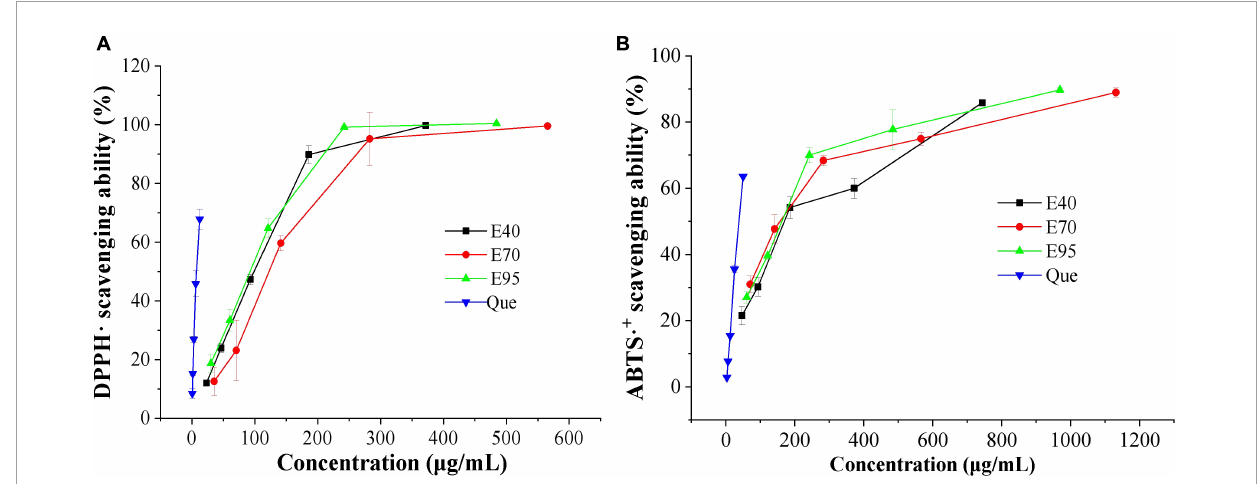
FIGURE1 DPPH · (A) and ABTS · + (B) scavenging ability of 40% (E40), 70% (E70), and 95% (E95) ethanol extracts of PRA.